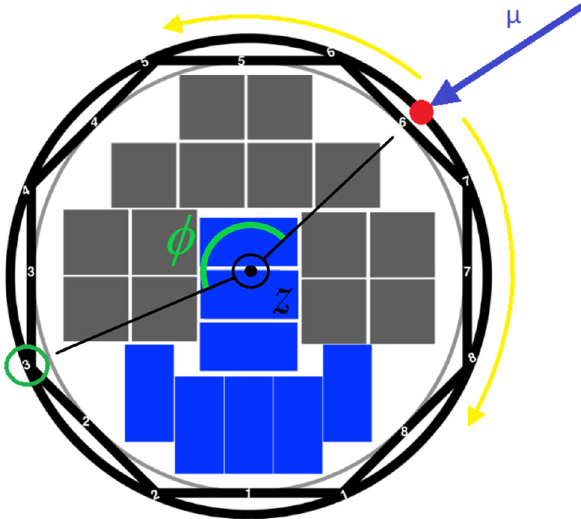
Fig. 8 Scheme showing the light transmission in the OV lateral sur- face. When a charged particle hits the veto, scintillation light is emitted from the impact point (red dot in the picture). The generated light then travels through the scintillator both clockwise and counterclockwise. As an example, to reach the WLS fiber coupled to SiPM 3 (in the green circle) light has to cross the grooves containing the other fibers (photons traveling clockwise cross 4 grooves, while light moving counterclock- wise crosses 3 grooves)